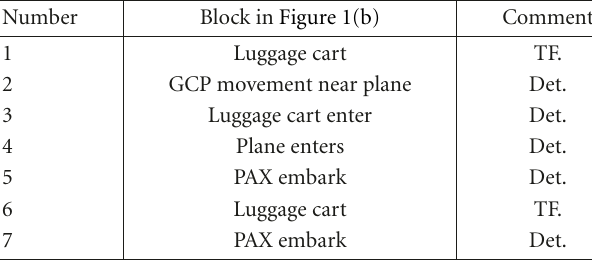
Table 2: TSA dataset: temporal segmentation of two blocks using the online BMS model. GCP = ground crew personnel, PAX = pas- sengers, Det. = segment detected, TF = tracking failed.